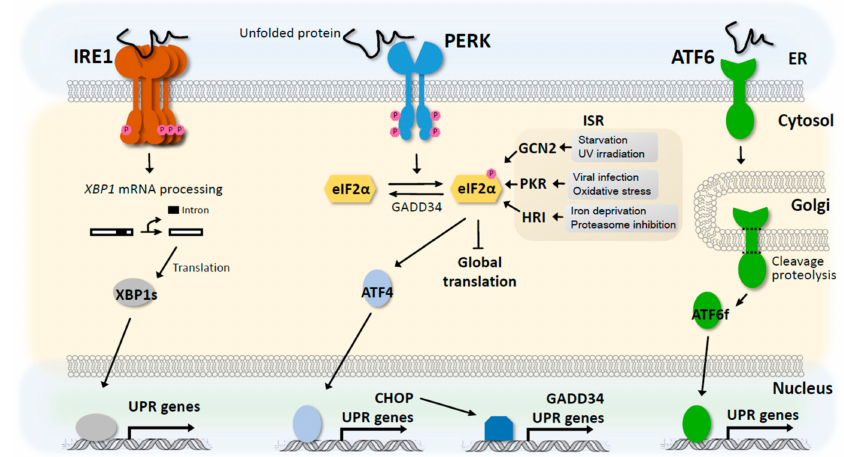
Figure 2. ER stress, unfolded protein response, and the integrated stress response. Multiple pathways, collectively known as the unfolded protein response, are activated by the detection of misfolded proteins in the ER. This ER stress can be sensed by ATF6, PERK, and IRE1, which act via distinct mechanisms to help alleviate the stress by increasing the protein folding capacity of the ER or decreasing the ER protein folding load. Whereas ATF6 and IRE1 mediate a direct and indirect (via mRNA splicing) transcriptional response, respectively; PERK acts to reduce global protein synthesis by enhancing eIF2 α phosphorylation. While global translation is reduced by phosphorylated eIF2 α , the translation of a small number of transcripts including ATF4 are preferentially induced, which in turn transcriptionally activate genes to promote survival under stress conditions or induce apoptosis. Together with PERK, GCN2, PKR, and HRI are three other kinases known to phosphorylate eIF2 α at serine 51 in response to di ff erent types of stress, forming the integrated stress response. Aside from HRI, which is not highly expressed in the brain, the ISR kinases have been shown to be activated in various neurodegenerative diseases and may contribute to the pathology by chronically depressing global protein